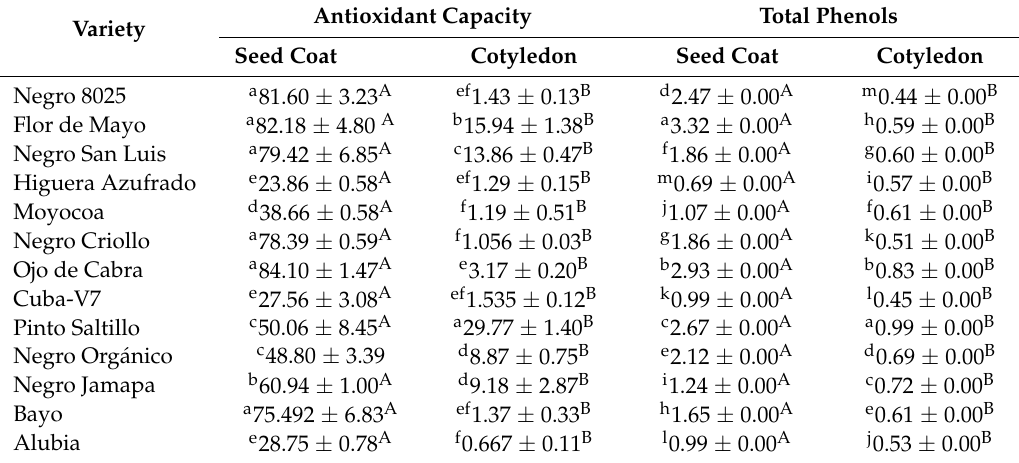
Table 1. Antioxidant capacity (% inhibition) and total phenols (mg gallic acid equivalents (GAE)/g) observed in seed coat and cotyledon of common bean varieties.